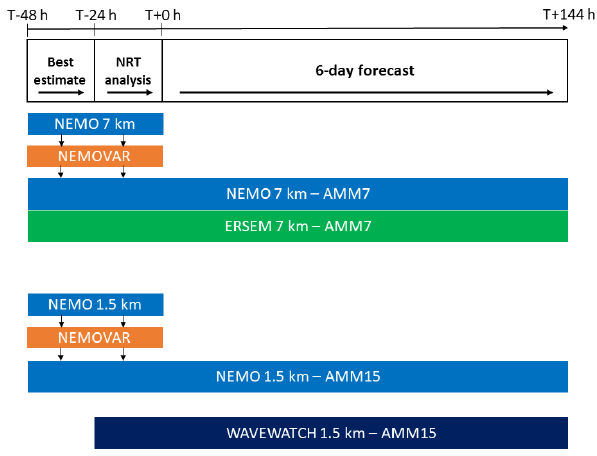
Figure 2. FOAM daily production cycle. The 7km system, top panel, has an ocean model coupled with a biogeochemical model and a variational assimilation scheme. The 1.5km system, bottom panel, has an ocean model with a variational assimilation scheme and a wave model, forced by the ocean model surface currents (not